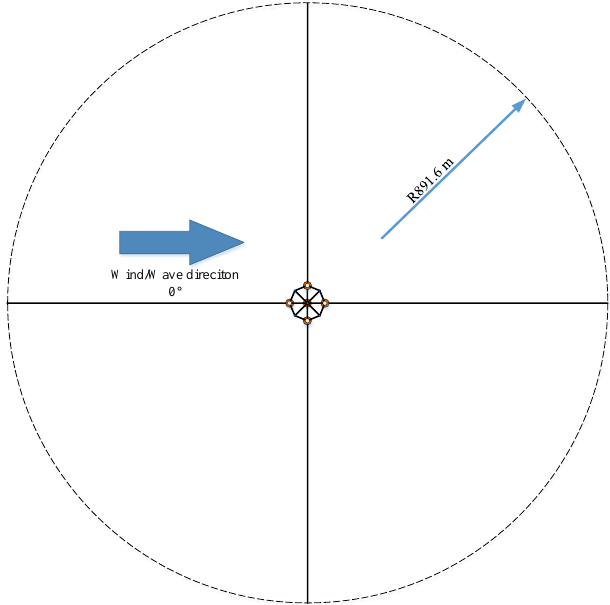
Figure 5. Top view of the mooring line system configuration. Table 5. Main properties of the NREL offshore 5 MW wind turbine.